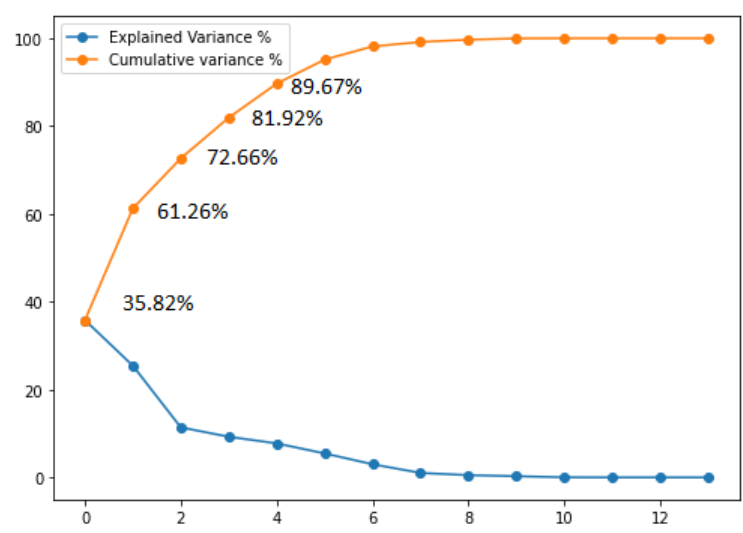
Figure 4. PCA Explained and Cumulative variances (x: Principle Components).